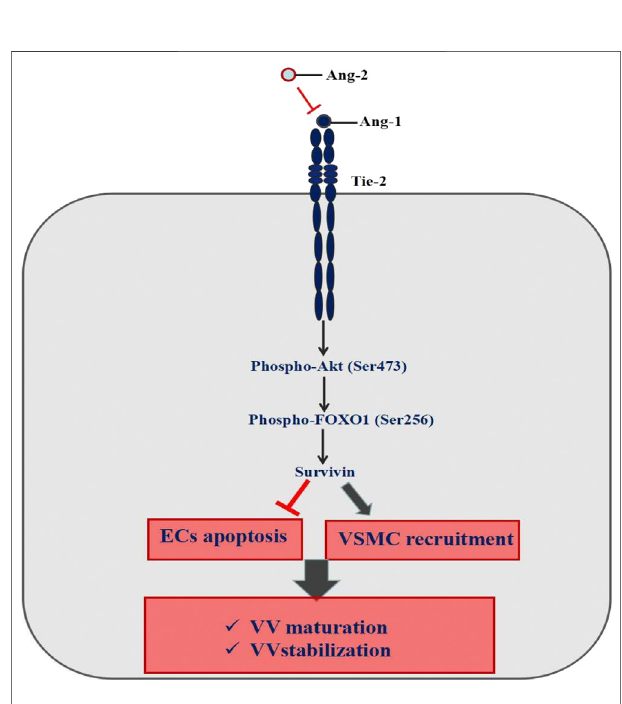
Frontiers in Pharmacology |